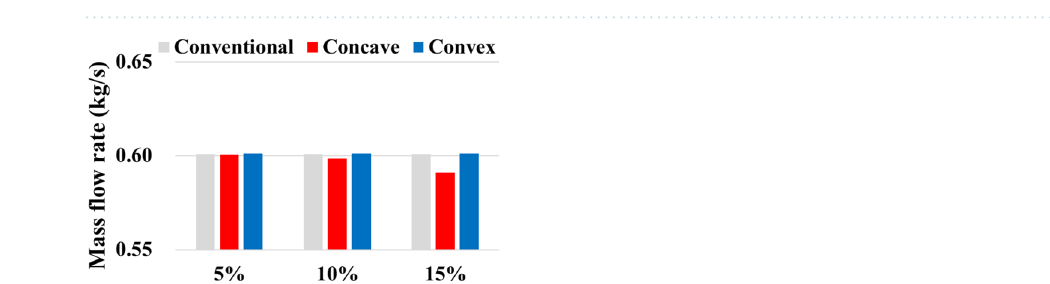
Figure 10. Shot mark distribution on substrate by Conventional, Concave, and Convex Models (Tecplot, https:// www. tecpl ot. com/).